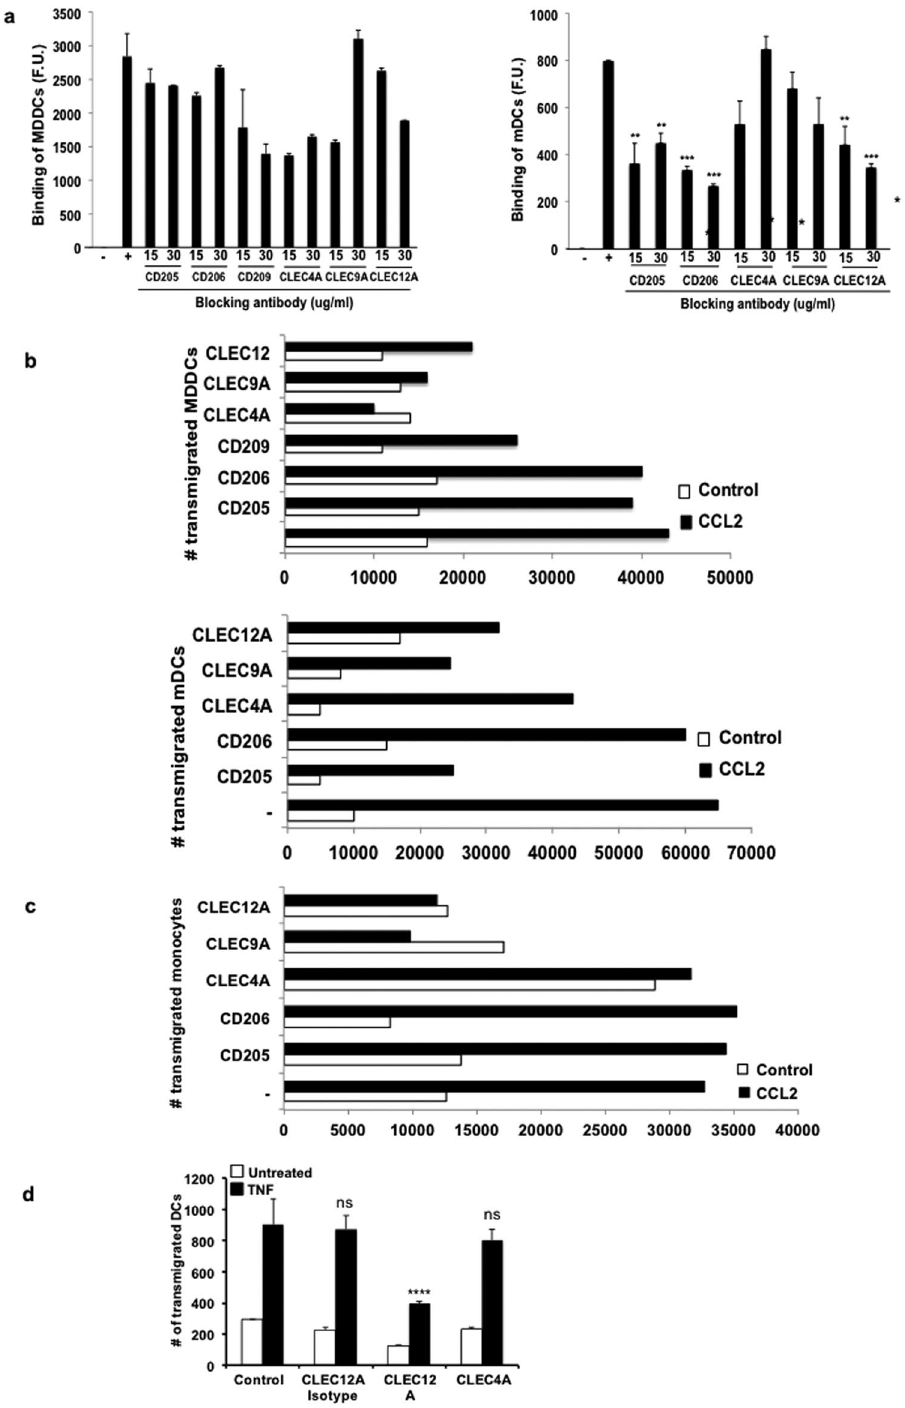
Figure 2. Effective CLR blocking impacts binding of DCs to brain endothelium and subsequent transmigration. DCs obtained from PBMCs were pre-treated with monoclonal antibodies fluorescently labeled prior to addition into a 96-well plate containing a confluent monolayer of TNF- α -activated hCMEC/D3 cells for 1 h and washed. Fluorescence was read at the 540 nm wavelength. For transmigration, pre-treated DCs and monocytes were added to the hCMEC/D3 cell monolayer and allowed to transmigrate for 24 h. Reduction in fluorescence intensities upon binding ( a ) and number of transmigrated cells ( b ) were observed in MDDCs and mDCs. ( c ) Bar graph showing number of migrated monocytes. ( d ) Similarly, migration of mouse splenic DCs across bEnd.3 cells is shown as a bar graph. Significance is represented when * P < 0.05, ** P < 0.01 and *** P < 0.001. Bar graphs are representative of two independent experiments run in triplicate. (See also Figures S2 and